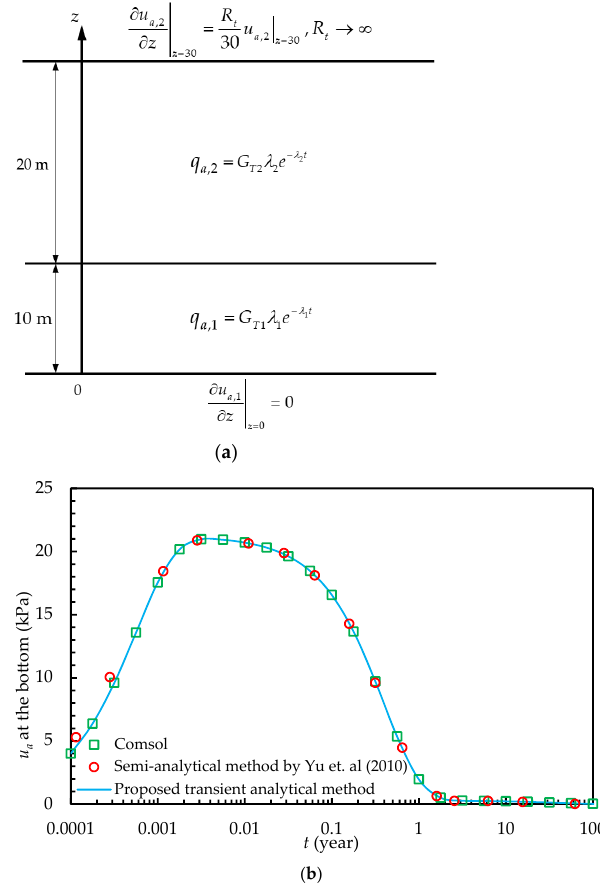
Figure 2. Comparison between the proposed transient analytical method and the numerical and semi-analytical method [19]. ( a ) Illustration of a two-layered landfill. ( b ) Comparison of the gas pressure values obtained using the different methods. Table 1. Model parameters used by Yu et al. [19].